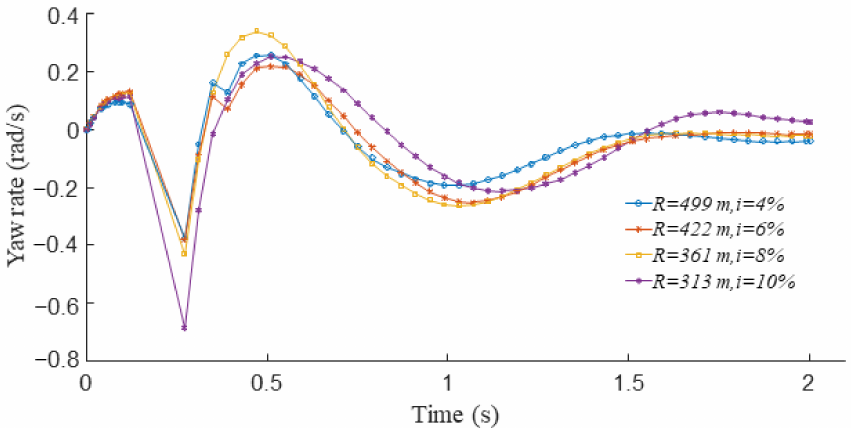
Figure 9. Simulation results of the yaw angular velocity at a driving speed of 100